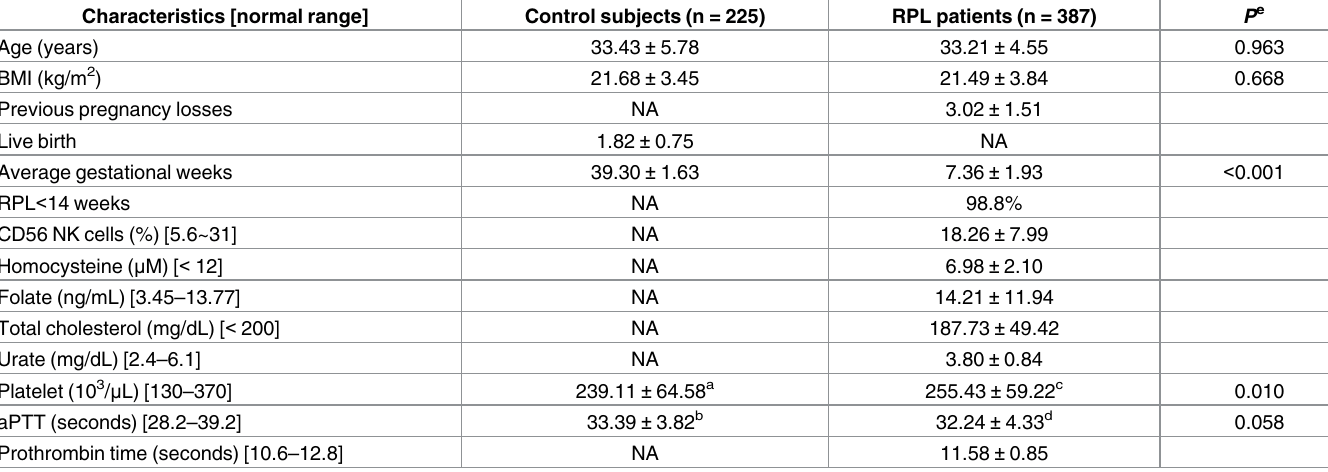
Table 1. Clinical profiles of RPL patients and control